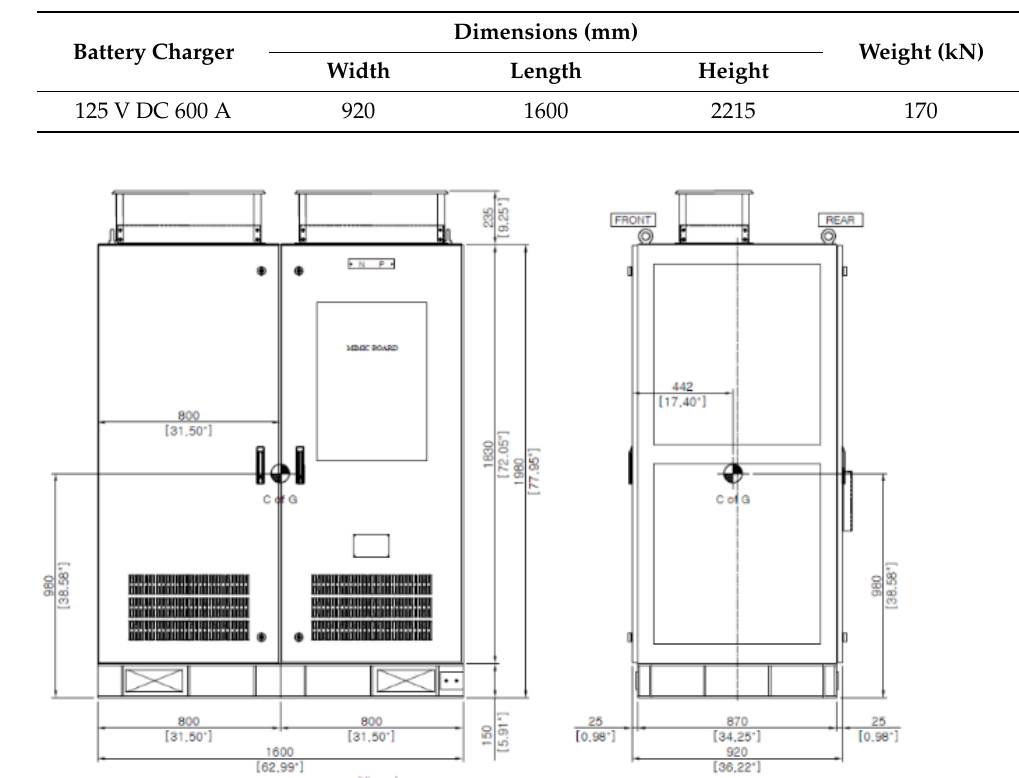
Table 1. Description of BC cabinet.